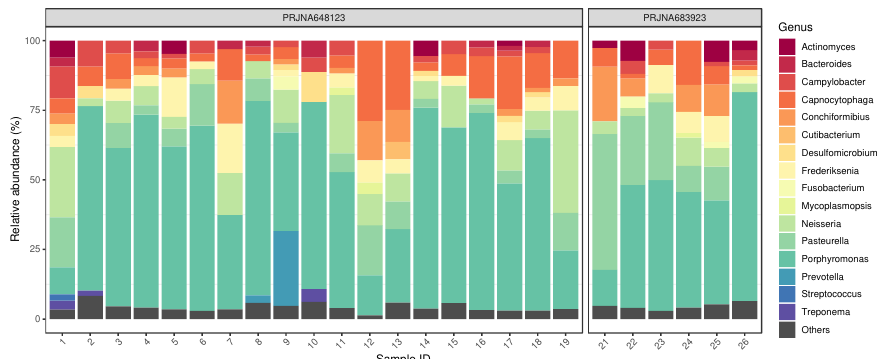
Figure 1. Saliva core bacteriome. The relative abundances of genera that achieved more than 1% of the bacterial hits in any of the samples. In the sample No. 20, no reads were classified to bacteria.